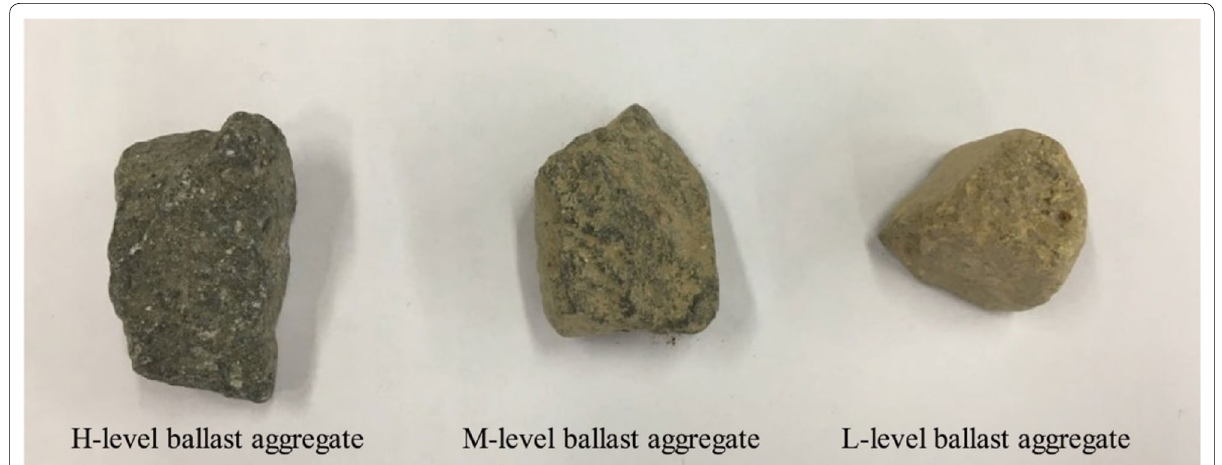
Fig. 7 Recycled ballast aggregates with three different cleanness levels.